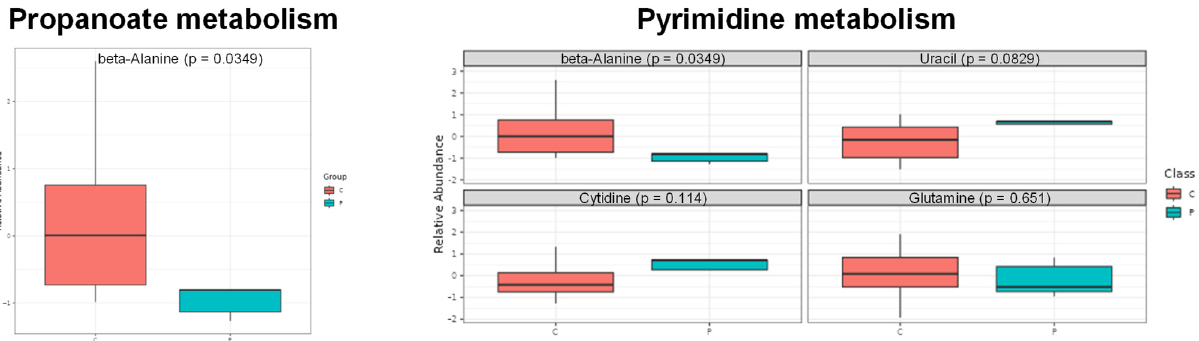
Figure A7. Detailed results of the enrichment analysis in Figure 5c. In each box plot, C and P indicate the data without and with depressive episodes, respectively.